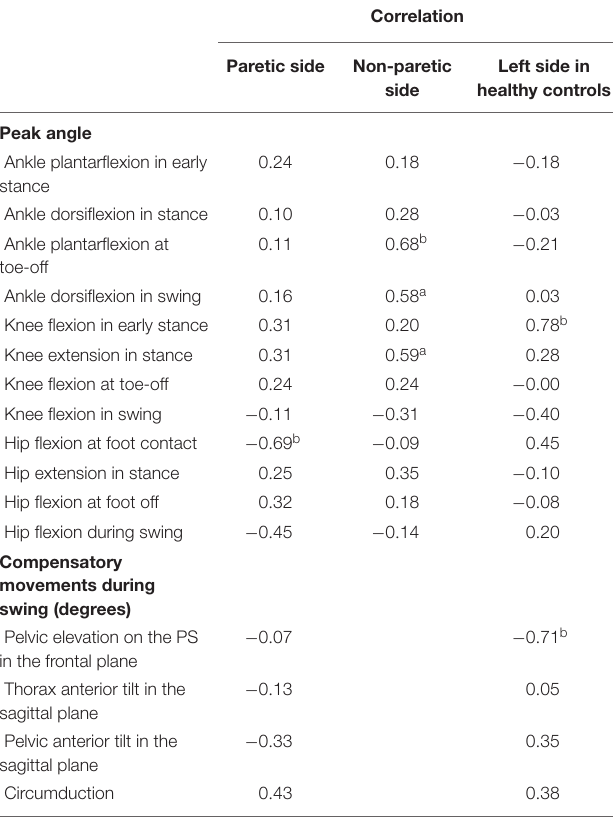
TABLE 6 | The correlations between walking activity and surface difference in kinematic parameters.